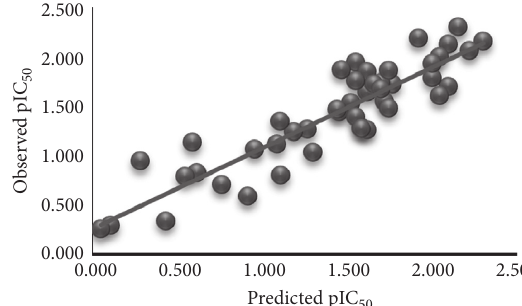
Figure 3: Correlation of observed vs. predicted pIC model